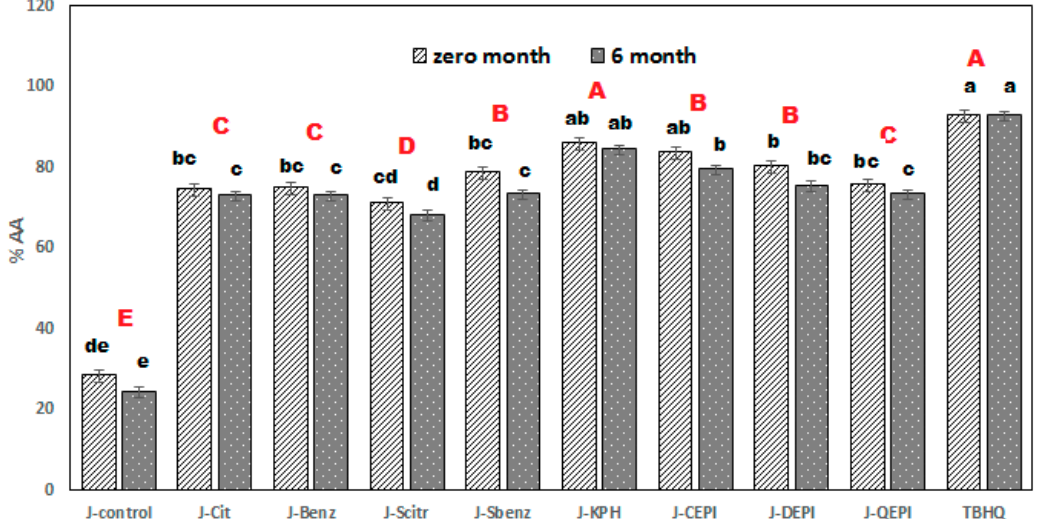
Figure 2. Antioxidant activity changes of cucumber juices during the storage period. Means with di ff erent lowercase letters that sit above columns are significantly di ff erent during storage, with di ff erent red capital letters, and significantly di ff erent between samples ( p ≤ 0.05). J-control, control cucumber